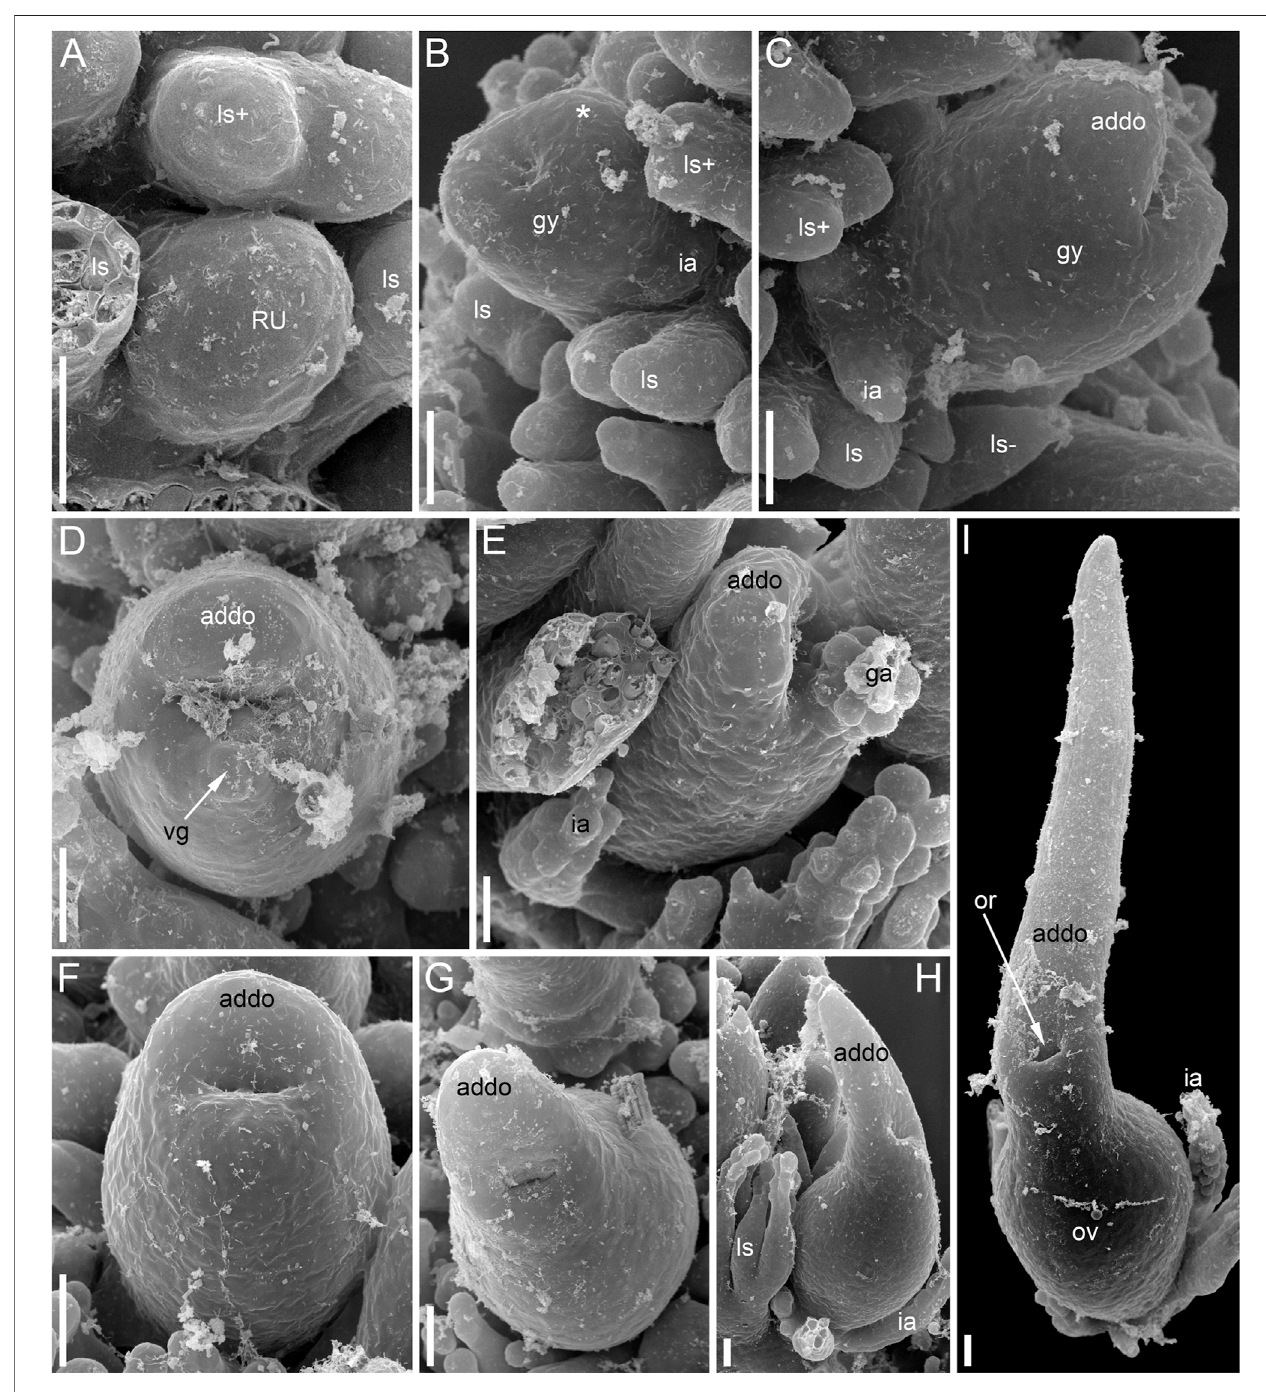
FIGURE8| Pistillate fl owerdevelopmentin Ceratophyllumtanaiticum (SEM). (A) Youngapparentlypistillatereproductiveunitinsertedbetweentwoleafysegments of a node. The bilobed leafy segment of the subsequent node is visible. Involucral appendages of the reproductive unit are not yet initiated. (B) Early stage of gynoecium development. The adaxial side of the gynoecium is indicated by asterisk. Involucral appendages are initiated. (C) Side view of a gynoecium with adaxial distal outgrowth initiated. Involucral appendages are still very short. (D) Pistillate fl ower (gynoecium) with vestigial abaxial glandular appendage. (E) Pistillate fl ower with well- developed abaxial glandular appendage. (F – I) Successive developmental stages of pistillate fl owers lacking glandular appendage. Scale bars = 30 μ m in (A – I) .